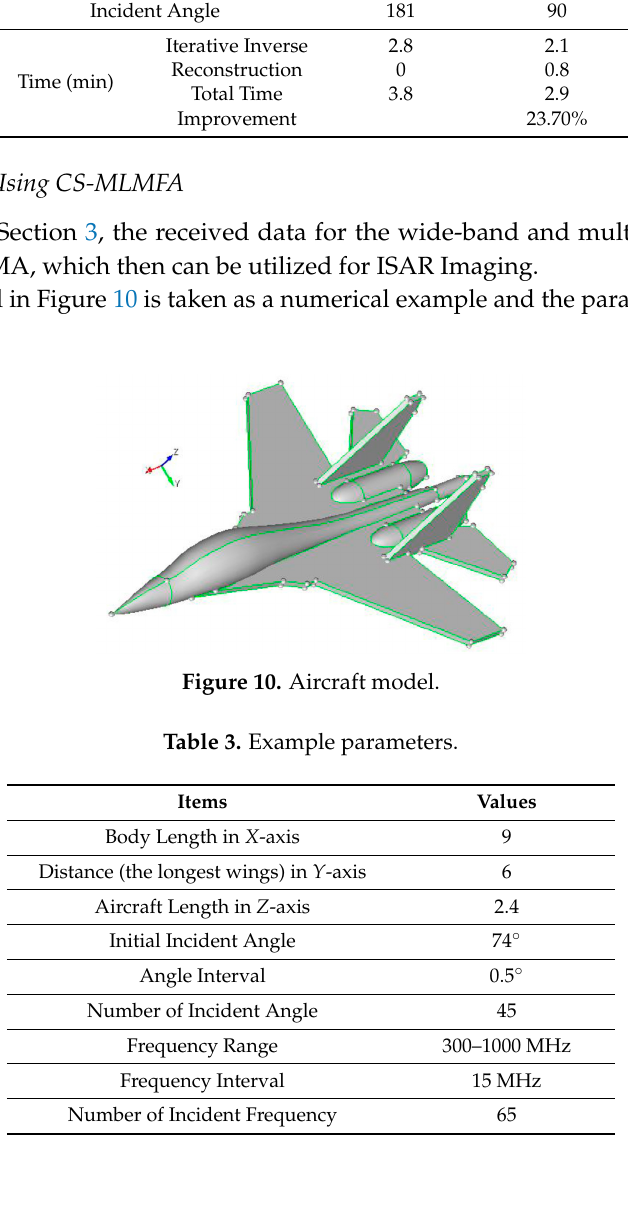
Figure 11. Aircraft model imaging by CS-MLFMA.